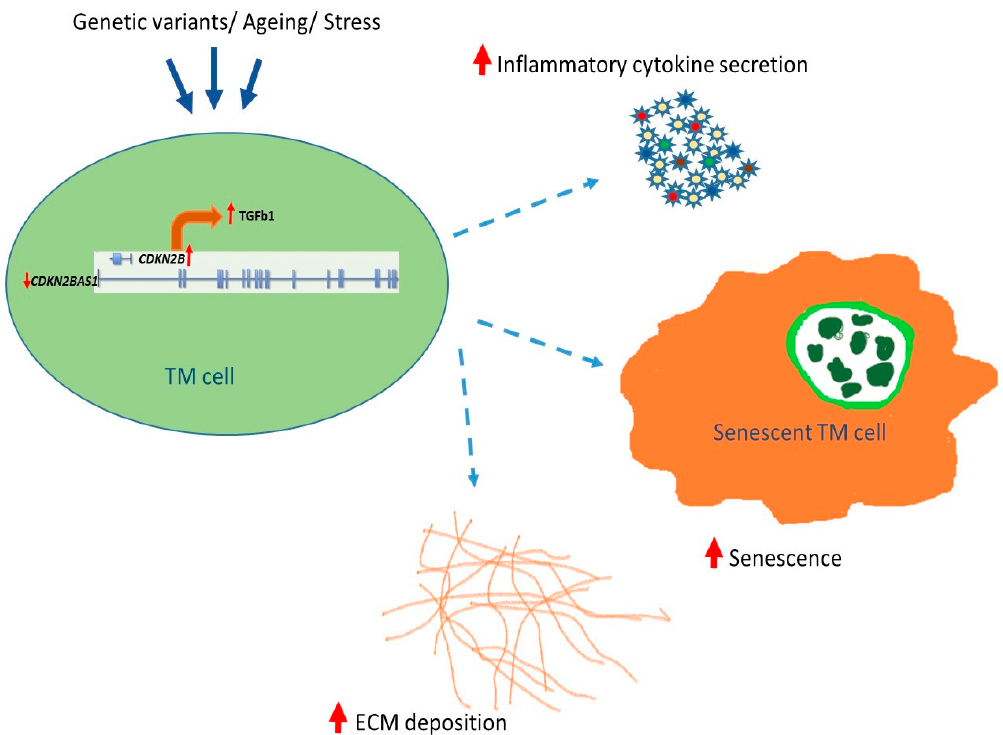
Figure 6. Schematic of the proposed mechanism of CDKN2B-AS1 knockdown mediated senescence- inflammatory phenotype in TM cells. Genetic variants, aging and oxidative or other stress could result in the downregulation of CDKN2B-AS1 , resulting in increased expression of CDKN2B (cell cycle arrest gene). CDKN2B directly or via TGF β signaling increases ECM deposition, cellular senescence and secretion of inflammatory cytokines in TM cells. Together, these will contribute to increased outflow resistance and TM cell death leading to POAG pathogenesis.